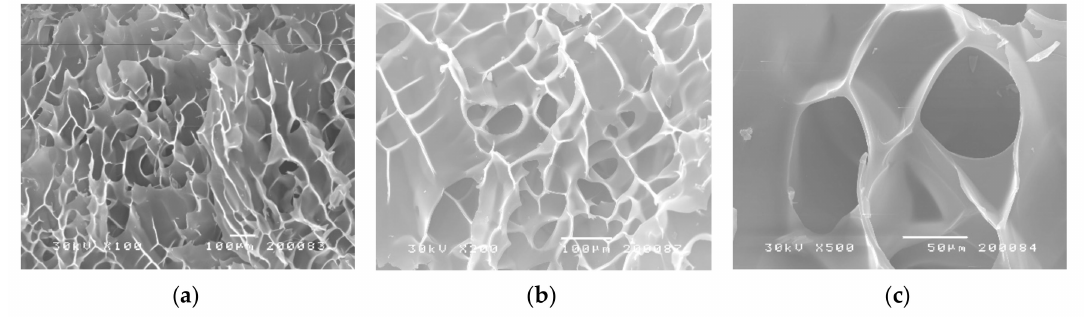
Figure 3. SEM micrographs of p( N iPMAm) hydrogel sample with 3.0 mol% of EGDM, swollen in the equilibrium state with magnification: ( a ) 100 × (scale bar 100 µ m), ( b ) 200 × (scale bar 100 µ m), and ( c ) 500 × (scale bar 50 µ